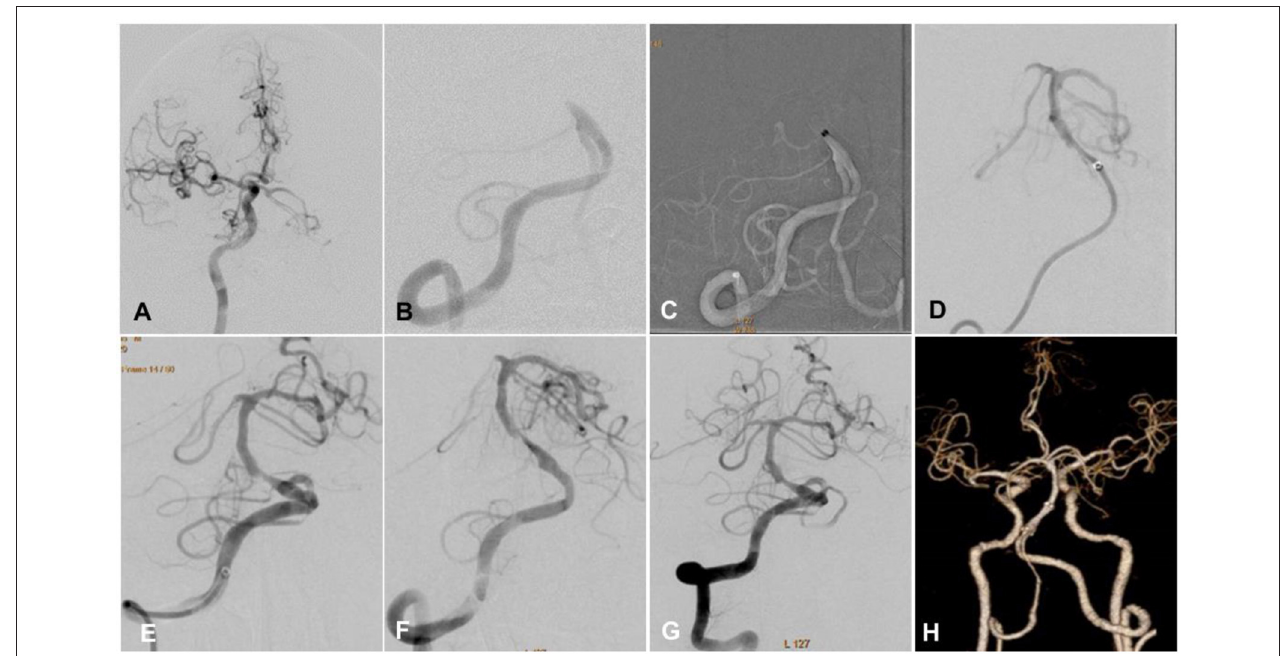
FIGURE 2 | A male patient in his 60s had paroxysmal dysphasia, left limb weakness for 1h, and coma for 30min. The NHISS score was 19. (A) Cerebral digital subtraction angiography showed lateral circulation and basilar artery tip, suggesting intracranial atherosclerotic stenosis-related large vessel occlusion (ICAS-LVO). (B) The right vertebral artery angiography demonstrated occlusion of the initial segment of the basilar artery. (C) A REACT68 suction catheter was navigated to the basilar artery proximal to the occlusion, and after 30s of negative pressure suction in situ , the retrograde blood flow in the catheter suddenly recovered. (D) Angiography confirmed that the anterior blood flow of the basilar artery returned to normal. (E) The aspiration catheter was withdrawn, and angiography revealed severe stenosis at the middle segment of the basilar artery as ICAS-LVO. (F) After 10min of observation, the stenosis degree was increased, and the forward blood flow gradually became worse. (G) A stent was implanted after balloon pre-dilation, with the blood flow reaching mTICI grade 3. (H) Computed tomography angiography of the head and neck was performed 3 days after operation, which indicated that the stent was unobstructed, and the basilar artery forward blood flow was stable. Seven days after operation, the patient was discharged, with the NIHSS score of